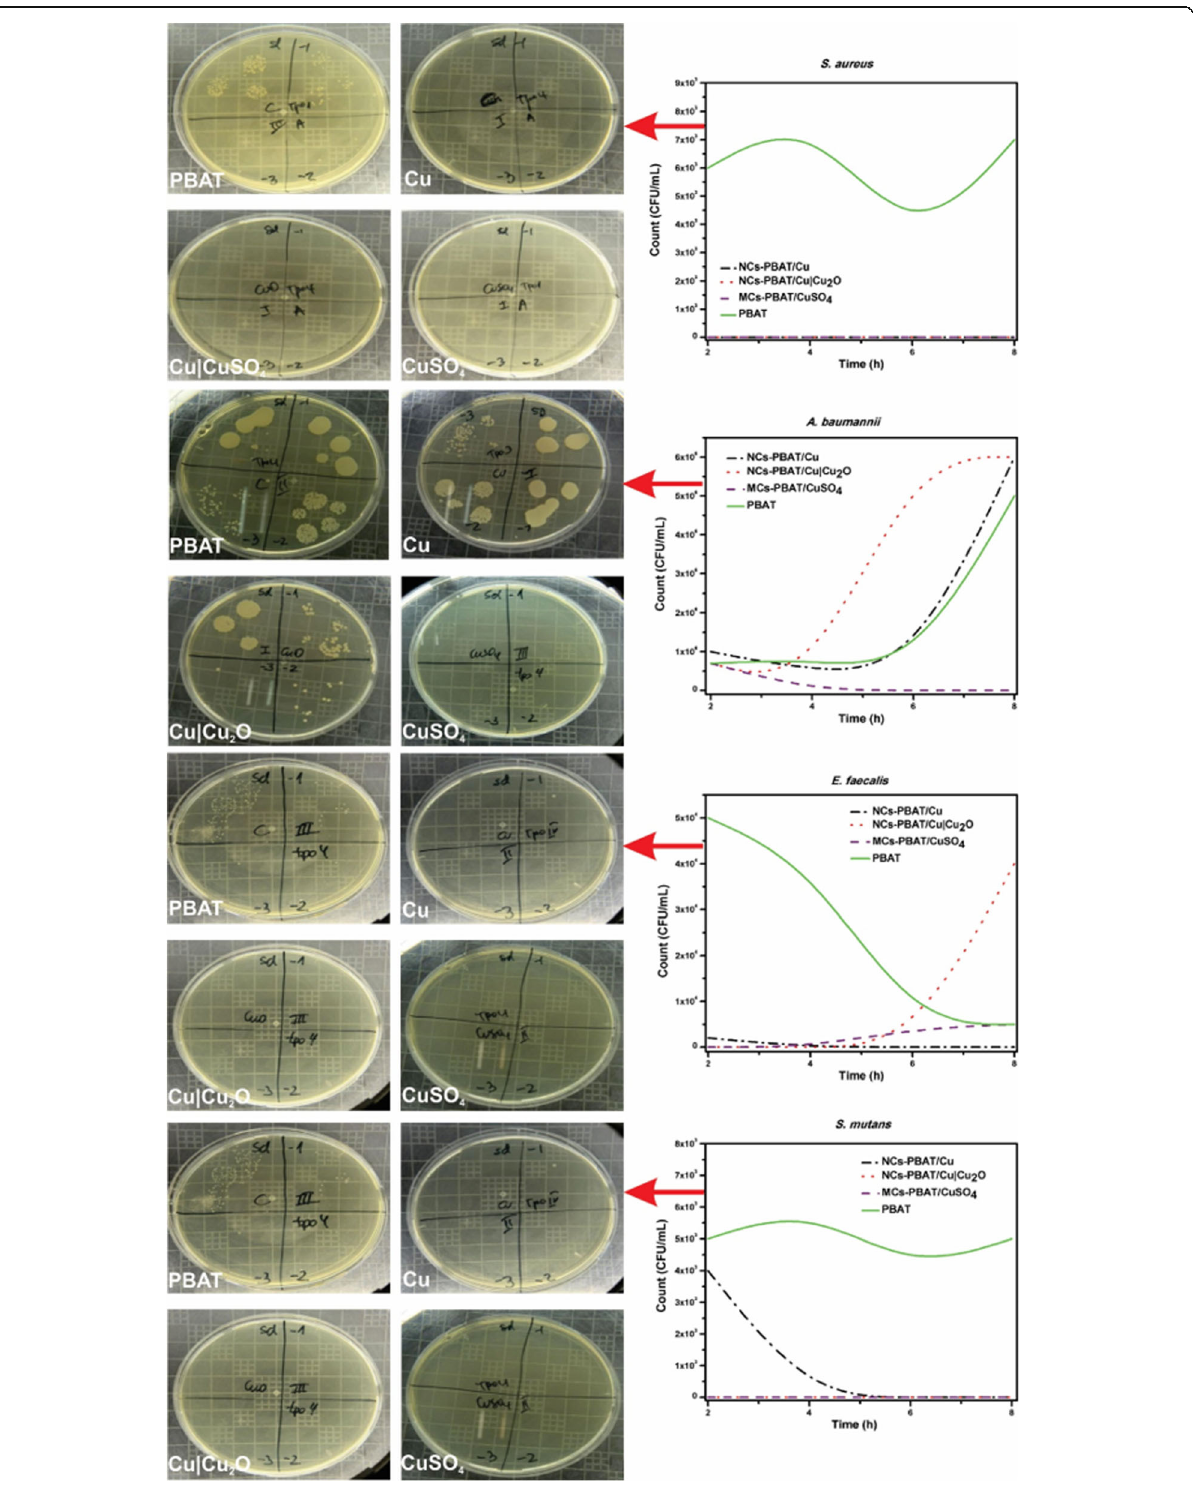
Fig. 6 Graphical analysis of colony count (CFU/mL) vs time (h) of PBAT, NCs-PBAT/Cu-3% NCs-PBAT/Cu|Cu 2 O 3%, and MCs-PBAT/CuSO 4 3% for each strain of bacteria. Enterococcus faecalis , Acinetobacter baumanni , Streptococcus mutans , Staphylococcus au